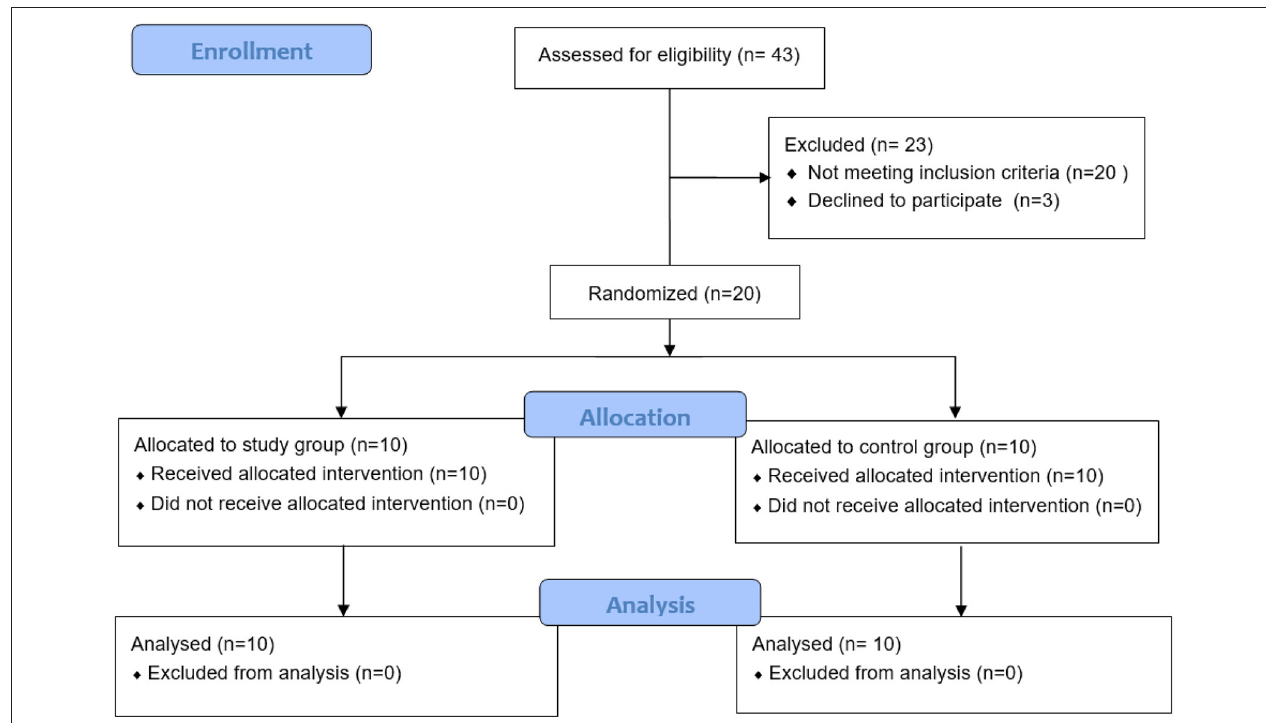
FIGURE 3 | CONSORT patient flow throughout the